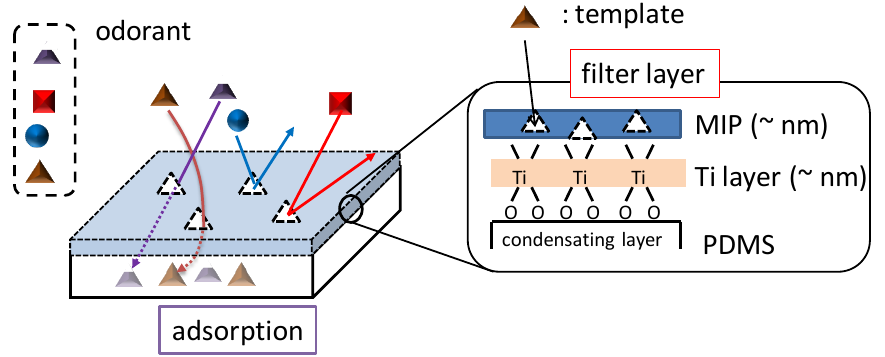
Figure 3. The layer structure of MIFAs sandwich with a MIP filter deposited on the PDMS